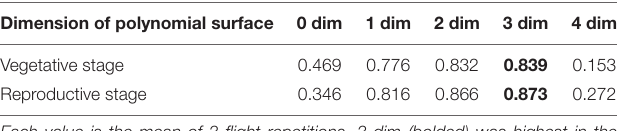
TABLE 4 | Correlation coefficients ( r ) between PH measured and PH SfM on the CSMs of Field